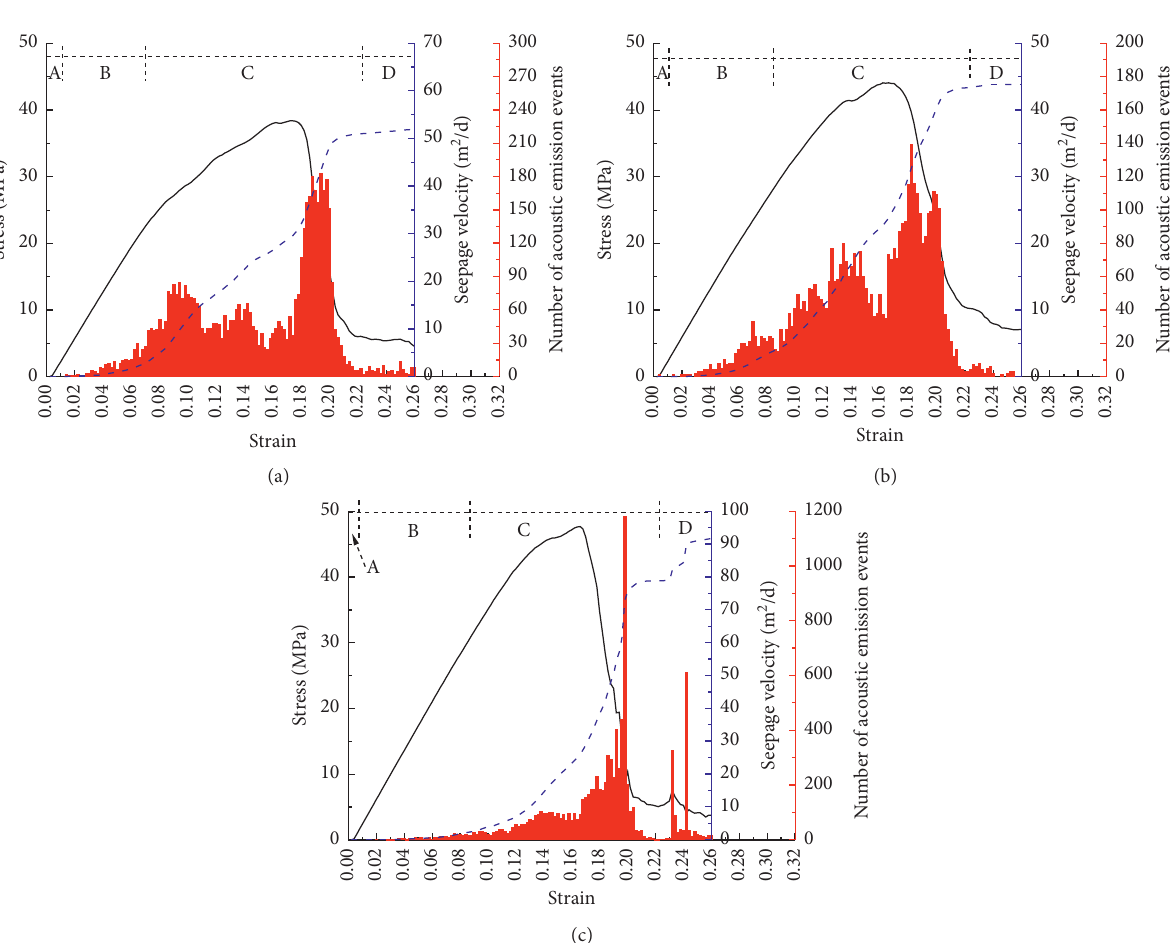
Figure 4: The relationships of stress, seepage velocity, AE events, and strain of cracked specimens under uniaxial compression. (a) β � 30 ° ; (b) β � 45 ° ; (c) β � 60 ° .